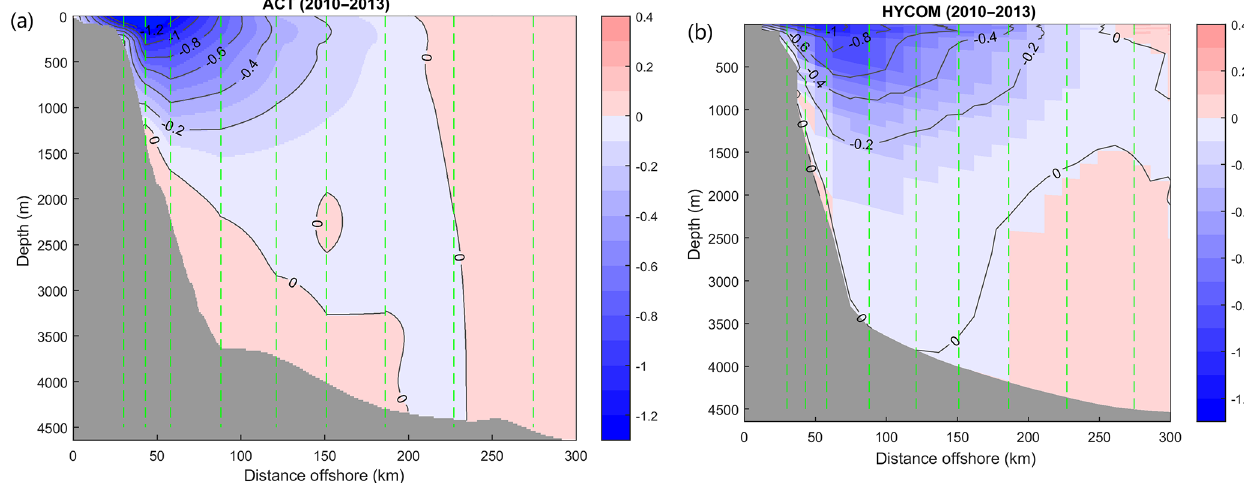
Figure 2. Time mean cross section of the velocity structure of the Agulhas Current across the ACT array (ms − 1 ) during the in situ ACT period (2010–2013) from (a) the ACT observations and (b) the HYCOM. Blue shading represents the negative, southwest current flow and pink shading represents the positive, northeast current flow. Contours are every 0.2ms − 1 . Dashed green vertical lines represent the nine locations of the mooring and CPIES pairs, the first line representing mooring A and CPIES pair P4P5 furthest